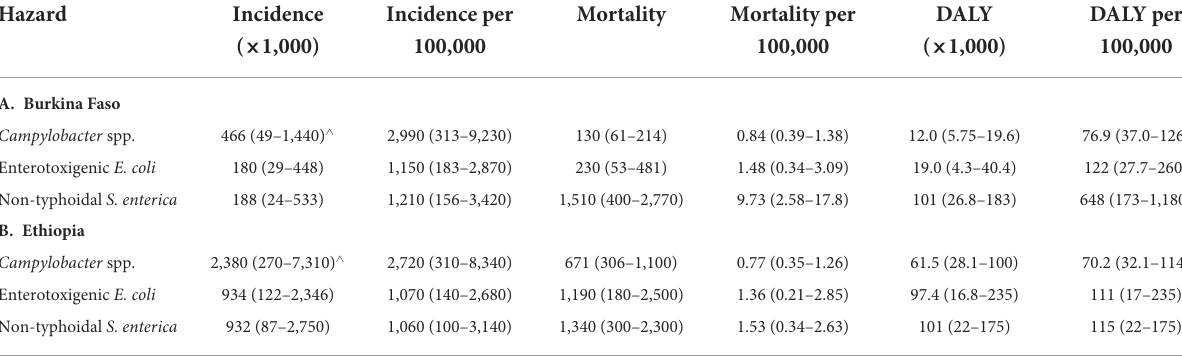
TABLE 2 Foodborne disease burden for three bacterial hazards in Burkina Faso and Ethiopia in 2010 (all ages) according to WHO FERG (Havelaar et al., 2015). Hazard